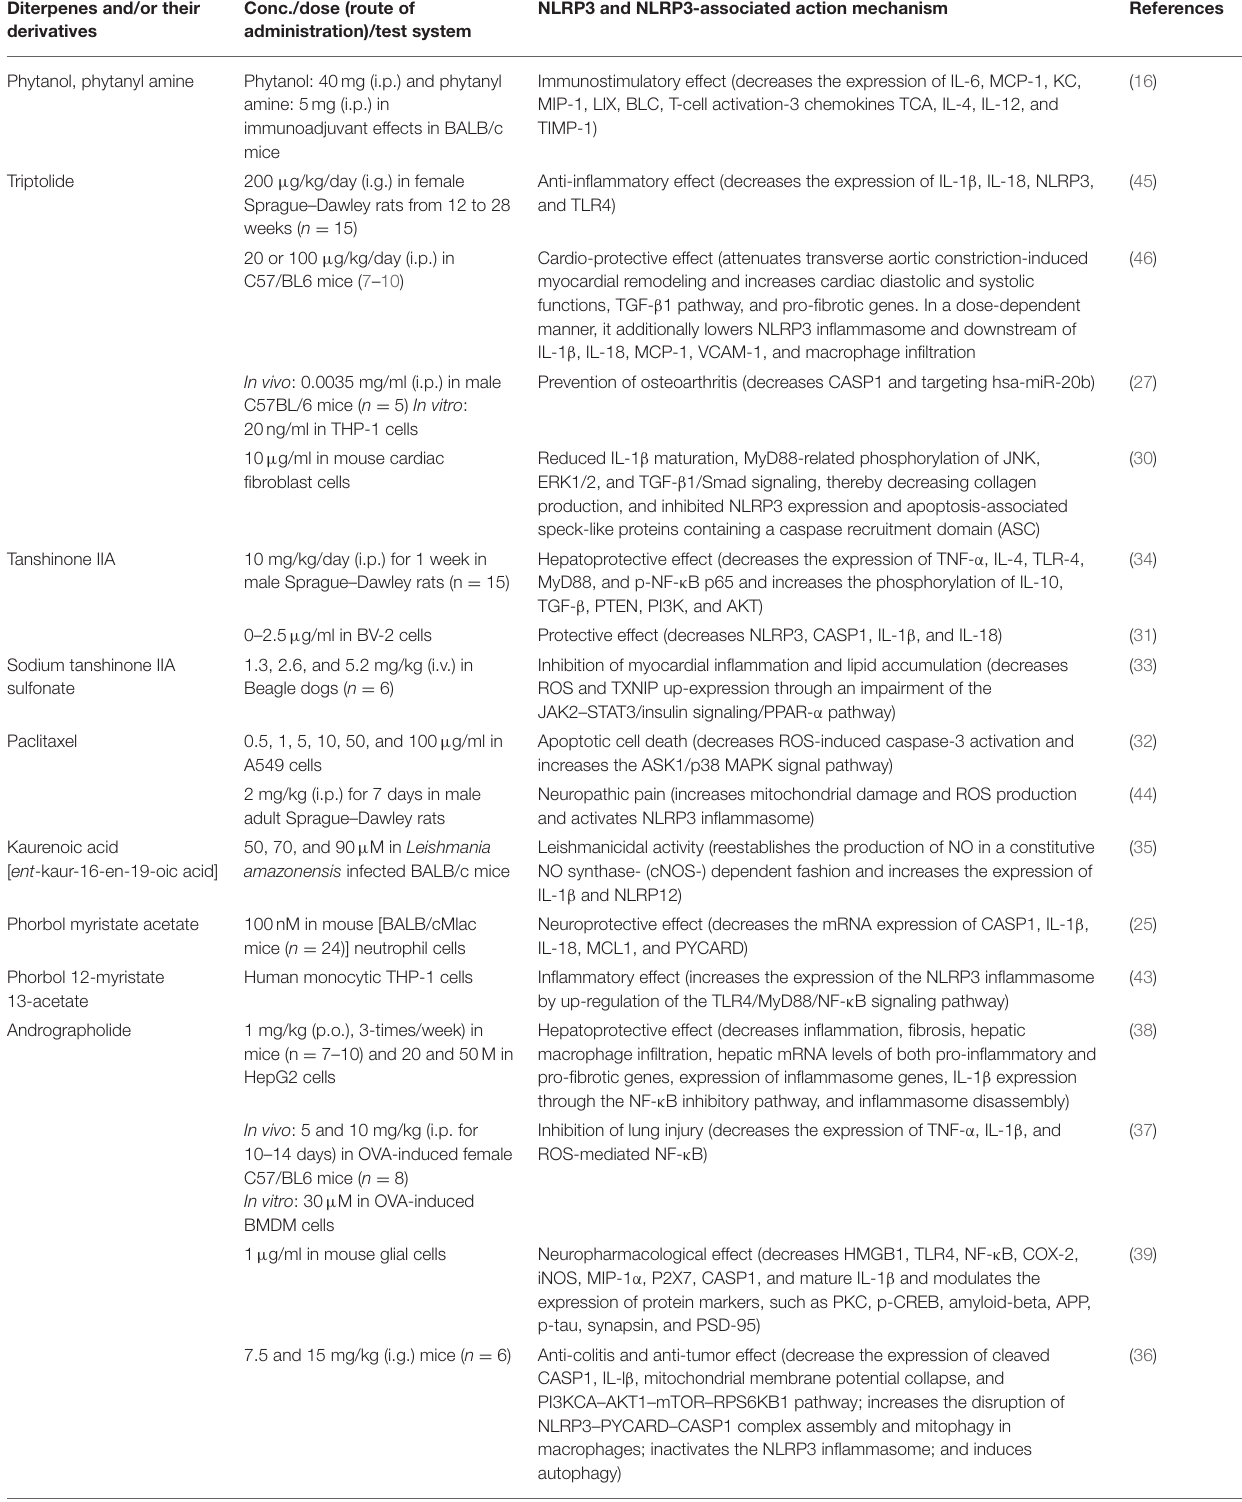
TABLE 1 | Summary of bioactivities of diterpenes and/or their derivatives: test dose/conc., test system(s), and possible NLRP3 inflammasome and its associated mechanisms. Diterpenes and/or their